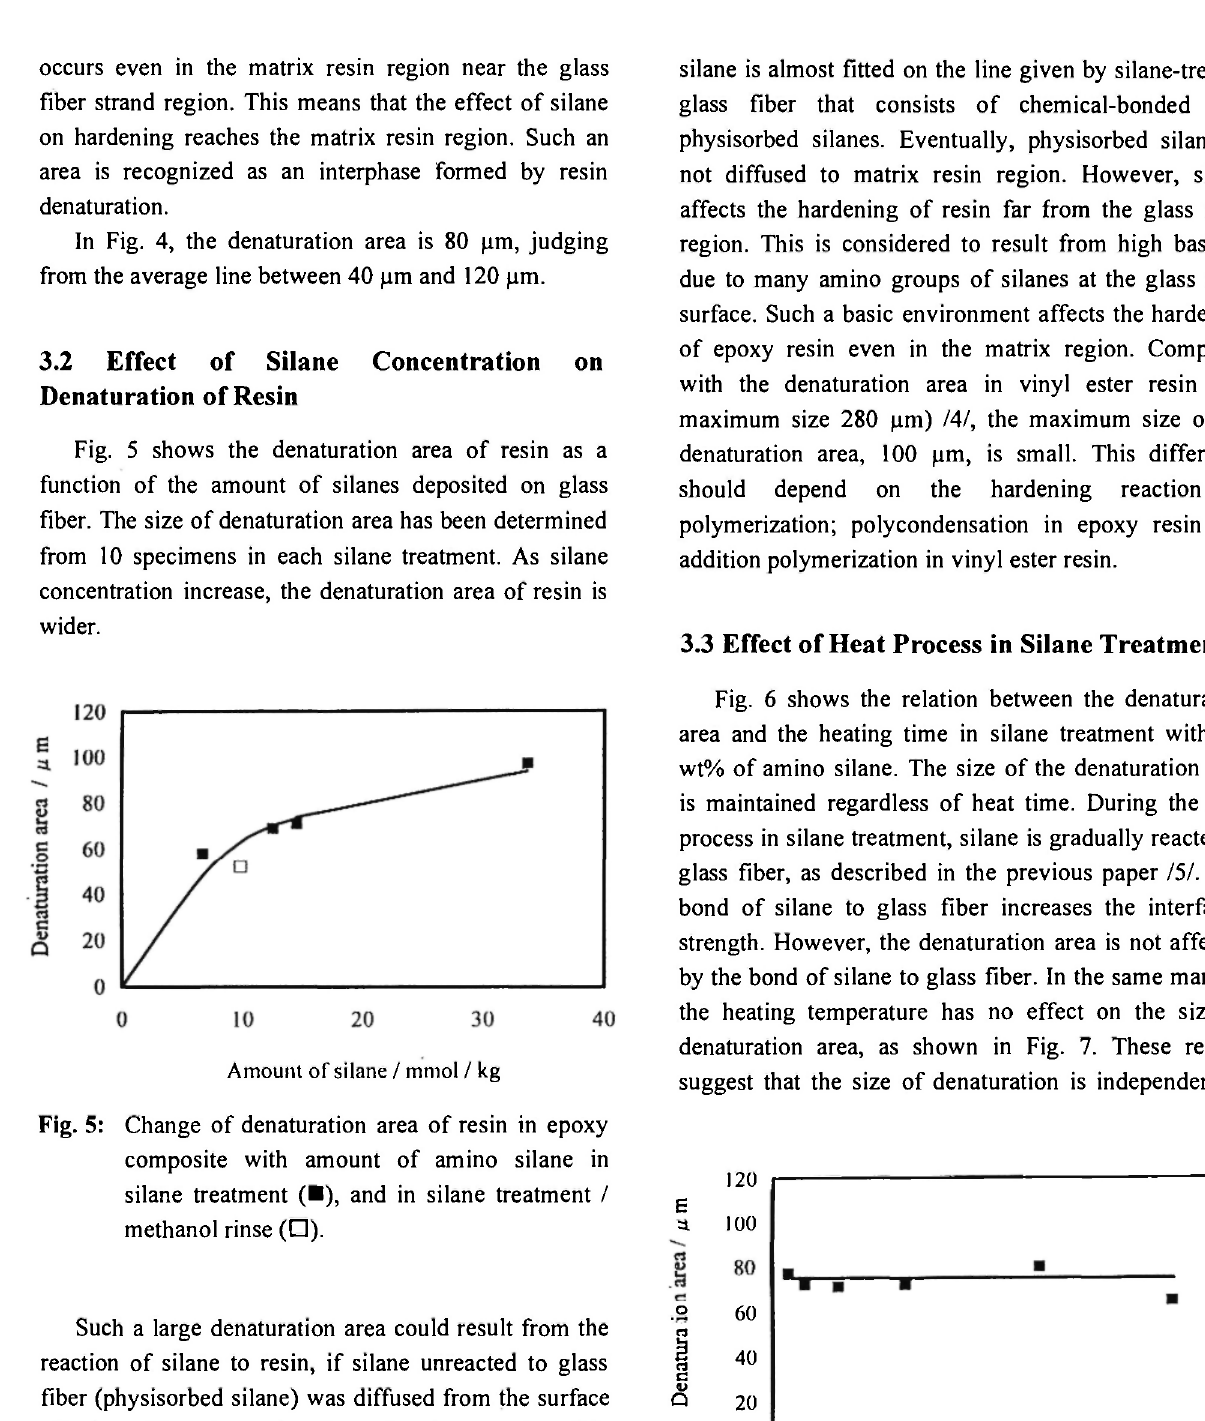
Fig. 6: Change of denaturation area of resin in epoxy composite with heating time in silane